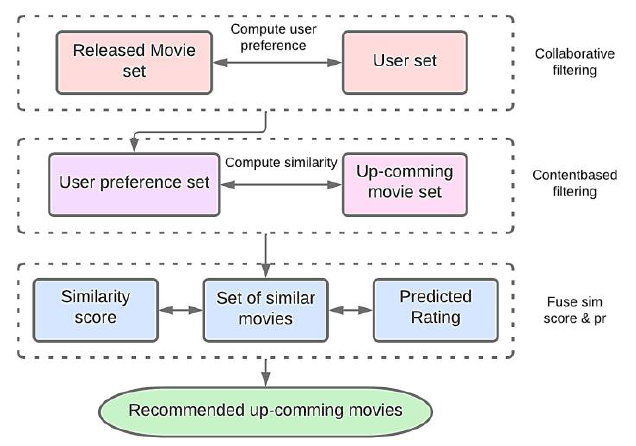
Figure 3. Framework of proposed hybrid recommendation system.